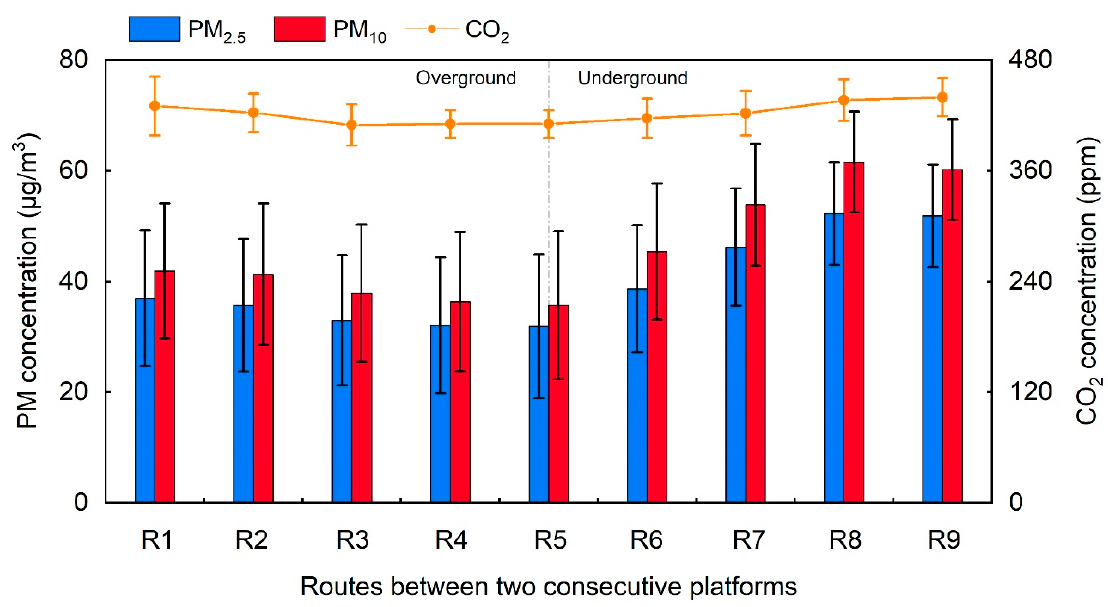
Figure 5. Average in-carriage PM and CO 2 concentrations between every two consecutive platforms including overground and underground conditions.